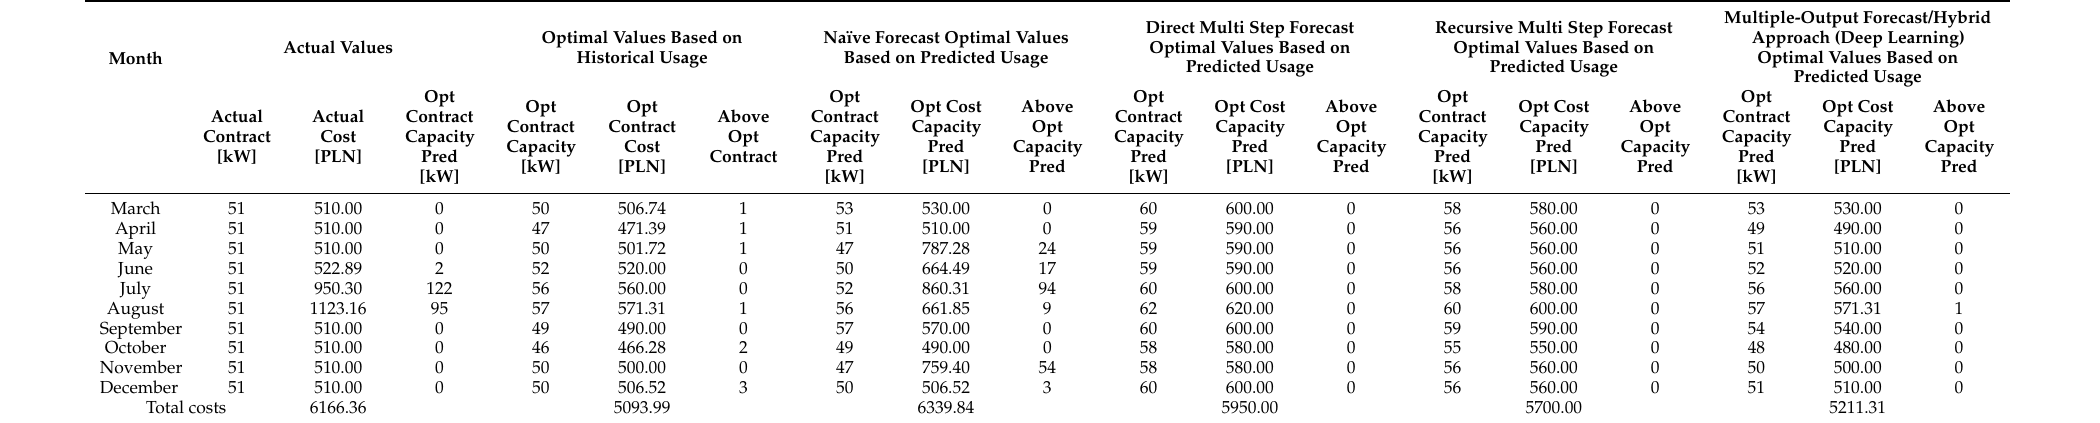
Table 1. The results with Q100 approach for C22a tariff user.